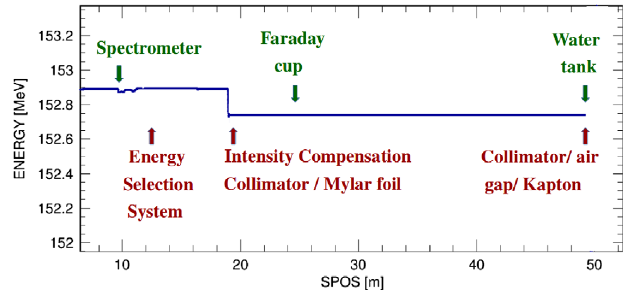
FIG. 8. Average beam energy along the beamline from the degrader to the coupling point of Gantry 3. The causes of the energy reduction are highlighted in red, while in green the devices used for the